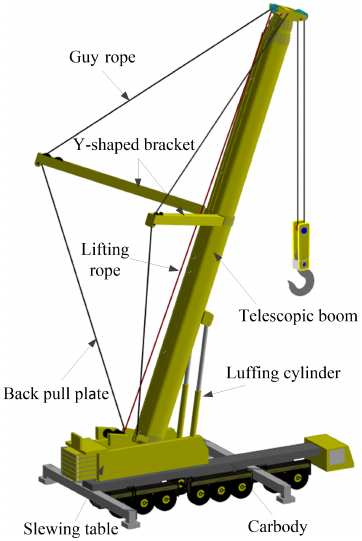
Figure 1. All-terrain crane